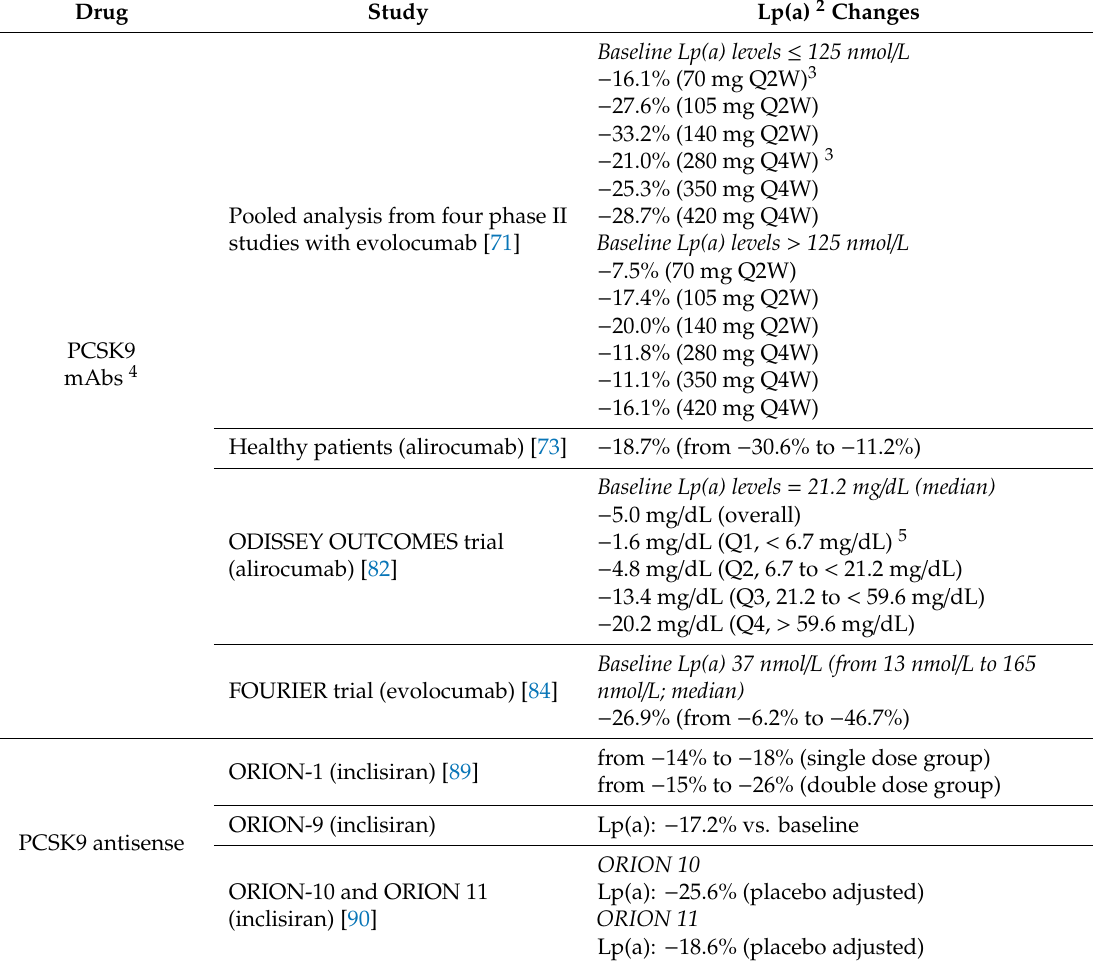
Table 2. Impact of PCSK9 1 inhibitors on lipoprotein(a)